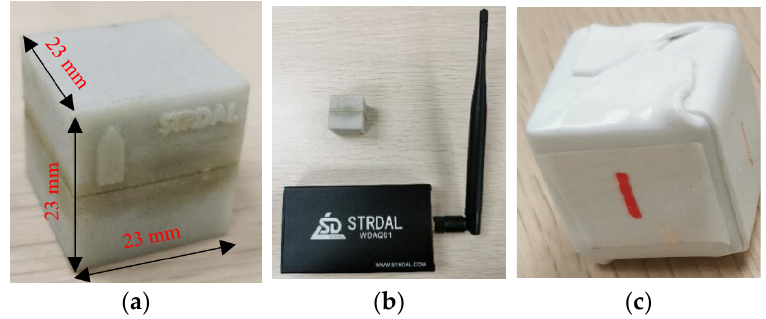
Figure 1. The SmartRock sensor: ( a ) dimensions of the shell; ( b ) the portable signal receiver; ( c ) the thermal insulation layer.